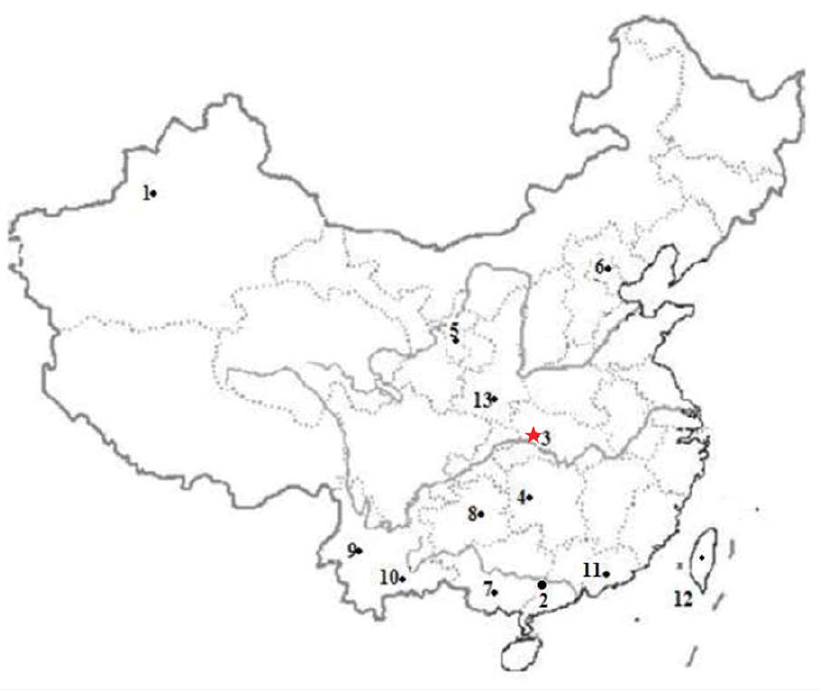
Figure 1. Map showing the sites of the populations used in this study. 1,Uyghur 2,Southern-Han 3,Tujia 4,Miao 5,Hui 6,Northern-Han 7,Bouyei 8,Shui 9,Bulang 10,Hani 11,Minnan 12,Taiwan-Aborigines 13,Middle-Han.